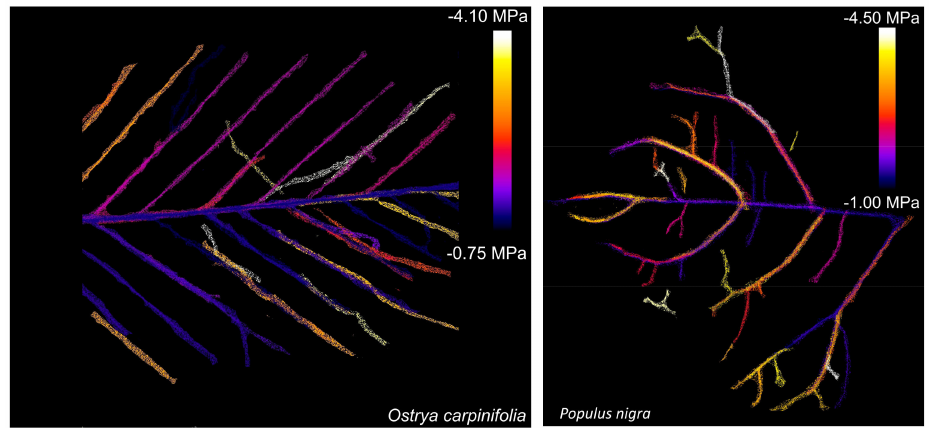
Figure 2. Patterns of embolism formation in the major vein network of Ostrya carpinifolia ( left ) and Populus nigra ( right ). Di ff erent colors indicate the di ff erent values of leaf water potential at which embolism was detected in the di ff erent